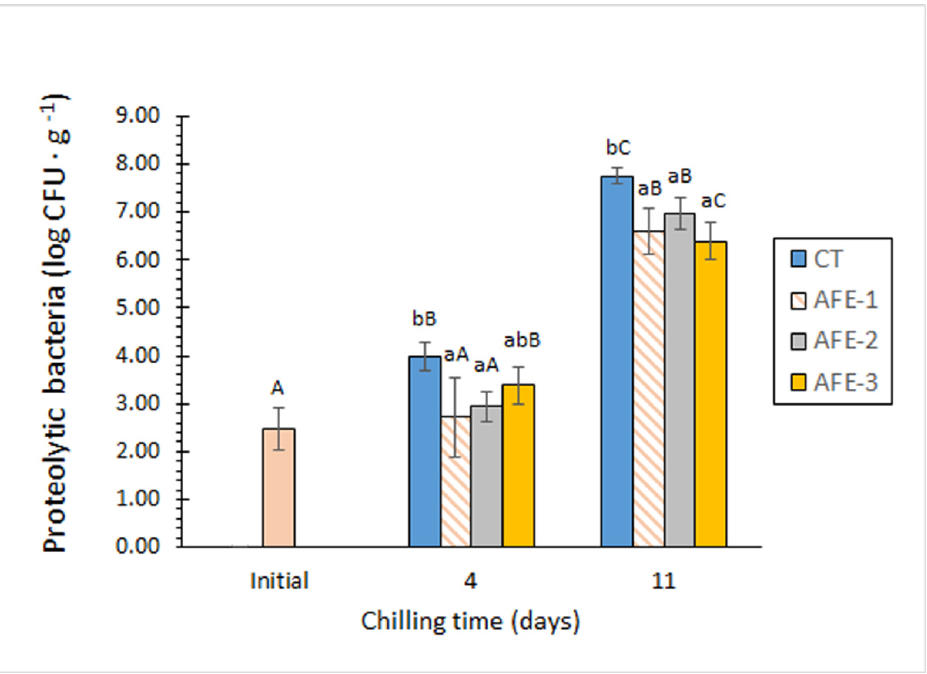
Figure 2. Proteolytic bacteria (log CFU·g − 1 muscle) in chilled mackerel subjected to different icing conditions. Mean values of three replicates ( n = 3); standard deviations are expressed by bars. Mean values accompanied by different lowercase letters (a, b) denote significant differences ( p < 0.05) as a result of icing conditions; mean values accompanied by different capital letters (A–C) denote significant differences ( p < 0.05) as a result of storage time. Icing conditions (CT, AFE-1, AFE-2, and AFE-3) as expressed in Figure 1. Table 5. Evolution of chemical parameters * related to microbial development in chilled mackerel subjected to different icing conditions **.